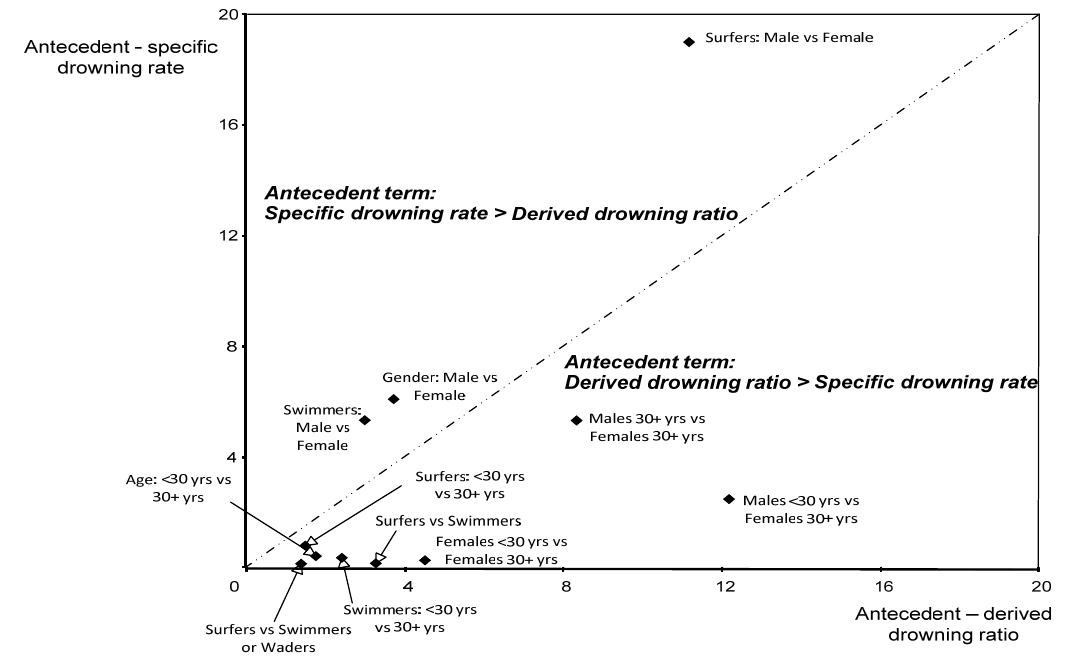
Figure 3. Comparisons of risk analysis drowning ratios and specific drowning rates.